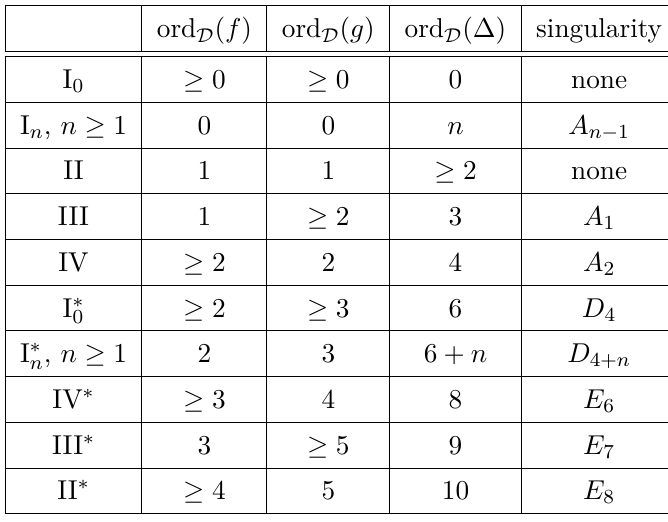
Table 1 . Kodaira’s classification of fiber